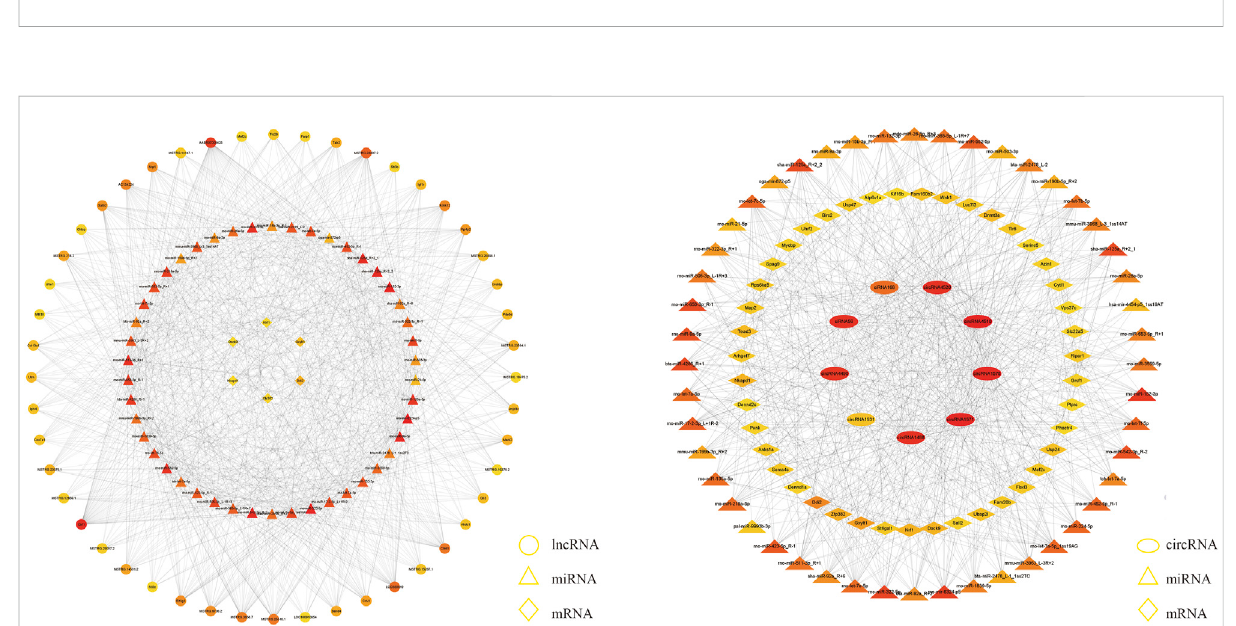
FIGURE 4 A The lncRNA-miRNA-hub mRNA network. In this fi gure, lncRNAs, miRNAs, and mRNAs are indicated by circles, triangles, and diamonds, respectively. The darker red color of a circle means that the gene has a higher degree and has more connections with other genes; conversely, the closer a circle color is to yellow, the lower the degree of the gene is, and the fewer connections it has with other genes. B The circRNA-miRNA-hub mRNA network. In this fi gure, circRNAs, miRNAs, and mRNAs are indicated by ellipses, triangles, and diamonds,